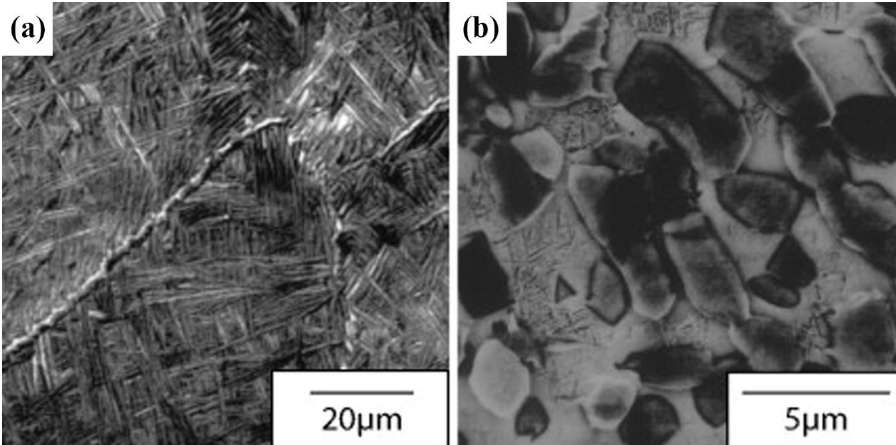
Figure 7. The differences in microstructure between hot forging in the single β -phase field in ( a ) and the α + β phase field in ( b ) are illustrated. The microstructure in ( a ) depicts large bcc β -phase grains with almost continuous grain boundary α -phase. The beta grains also contain a high volume fraction of Widmanstätten α -phase plates. The microstructure in ( b ) depicts smaller bcc β -phase grains with some martensite phases and large globular primary α -phase particles [105]. (Reprinted by permission